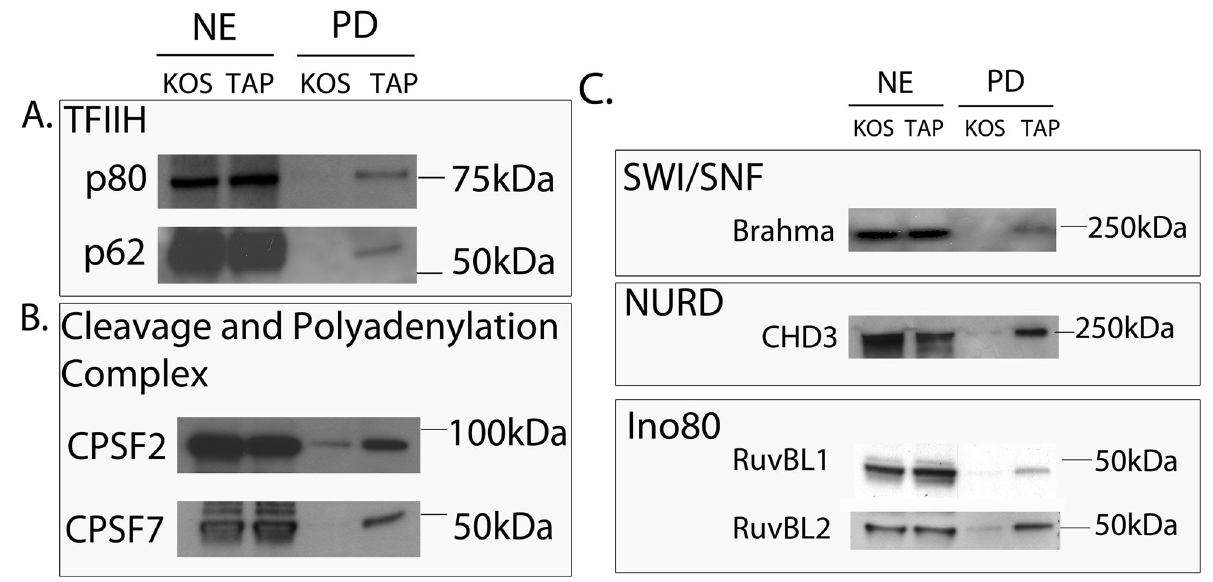
Figure 7. ICP4 containing complexes include TFIIH, cleavage and polyadenylation complex and chromatin remodeling complexes. Western blot analysis of nuclear extracts (NE) or affinity purified (PD) samples collected at 6 hpi using either wtICP4 (KOS) or TAP-wtICP4 (TAP) expressing viruses. Antibodies directed against (A) p80 and p62 of TFIIH, (B) CPSF2 and CPSF7 of the cleavage and polyadenylation complex and (C) Brahma of Swi/Snf, CHD3 of the Nurd complex, and RuvBL1 and RuvBL2 of the Ino80 complex were